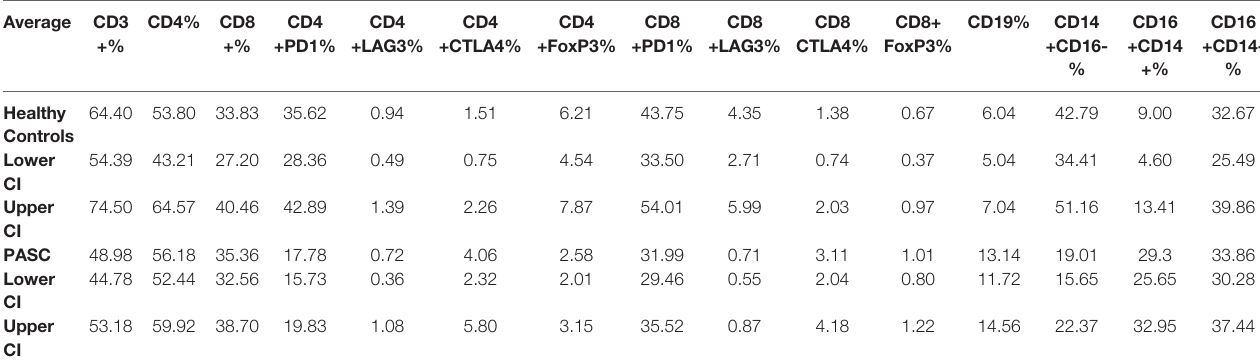
TABLE 1A | T-, B-cell, and monocyte